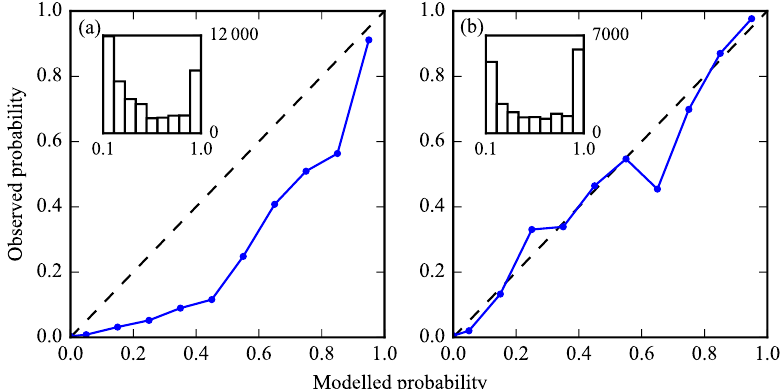
Figure 8. Reliability diagrams constructed from the probabilistic flood map generated by simulating all errors (a) and by simulating only errors in the elevation data and parameters (b) . The small histograms give the number of cells within each 10% bin of modelled flood